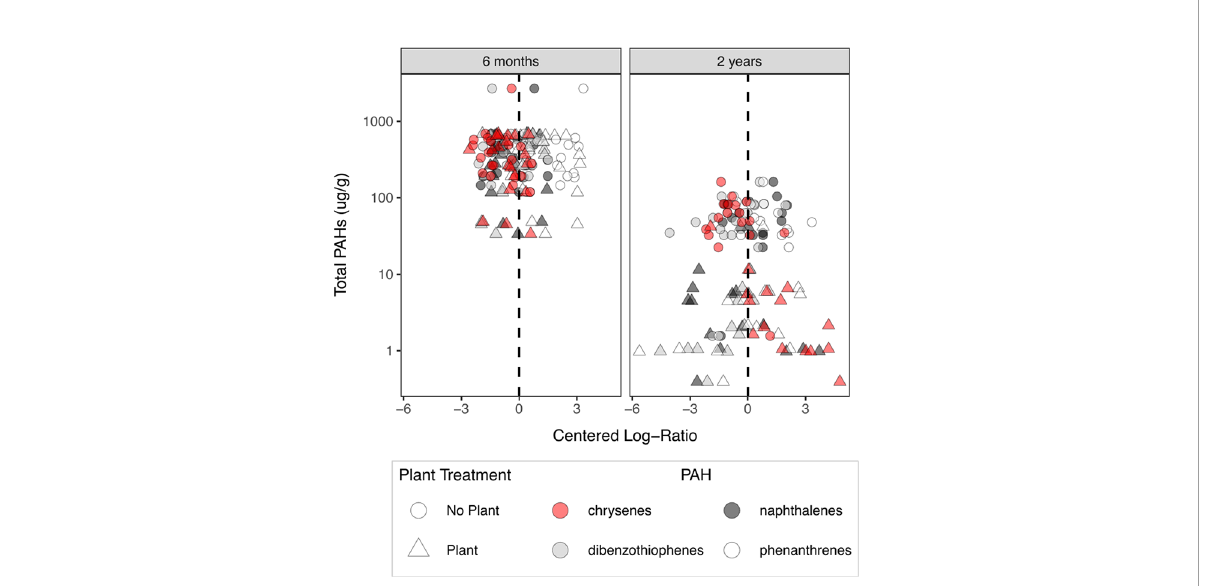
FIGURE 1 Relative abundances of PAHs 6 months into the experiment (left panel) and at the end of the experiment (right panel). The y-axis represents the total target PAHs measured for a sample. The x-axis represents the centered log-ratio of the PAHs, where the dashed line represents the geometric mean of the sample. Points to the left of the dashed line represent PAHs that were relatively less abundant than average in a sample and points to the right of the dashed line represent PAHs that were relatively more abundant than average. Target PAHs included one 2-ring PAH, two sets of congeners of 3-ring PAHs (colored in white and gray) and one type of 4-ring PAH (colored red). Triangles represent soil samples from mesocosms in which a plant was growing, circles represent soil from mesocosms with no